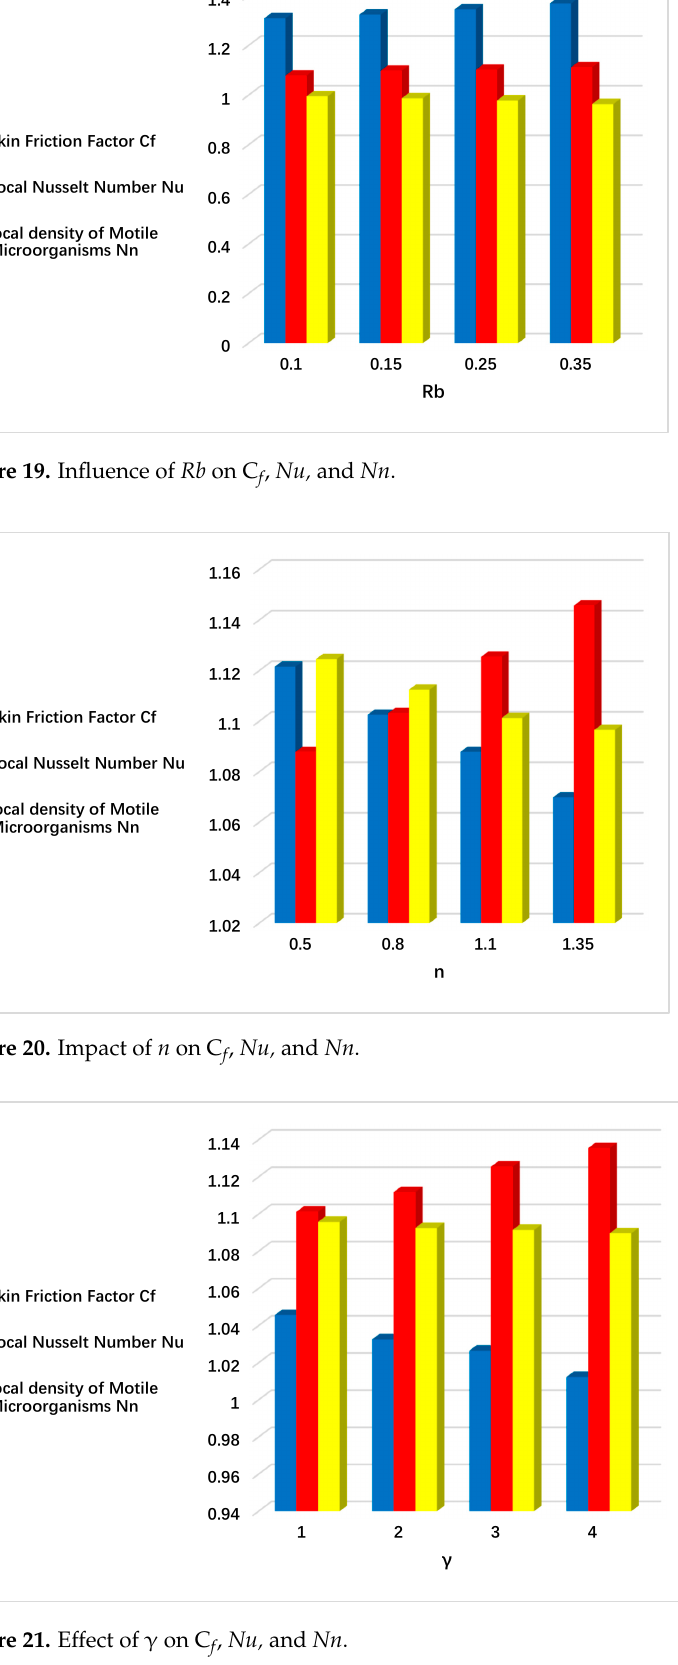
Figure 18. Influence of We against C f , Nu, and Nn .